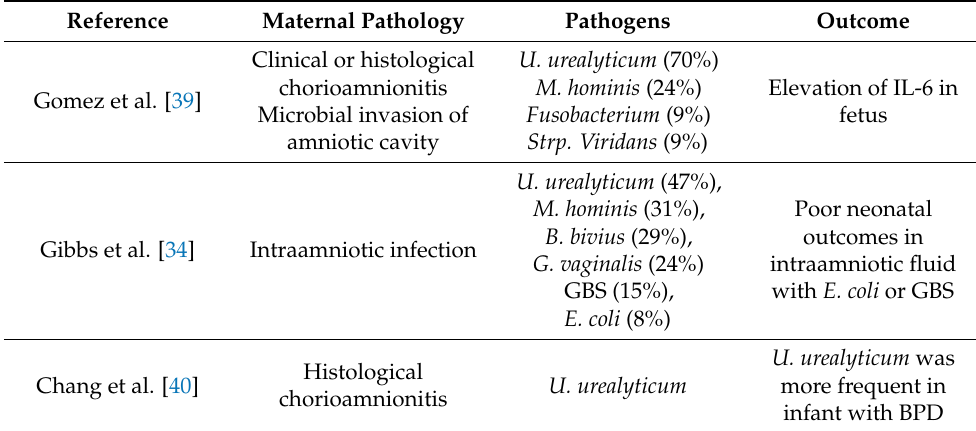
Table 1. Maternal pathology, association of pathogens and neonatal